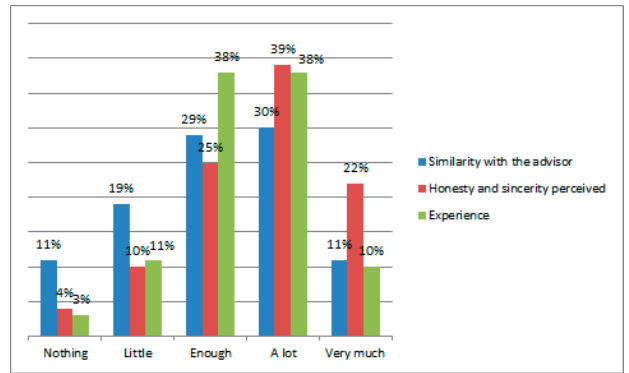
Figure 5. Consumer variables affecting trust of online reviews.